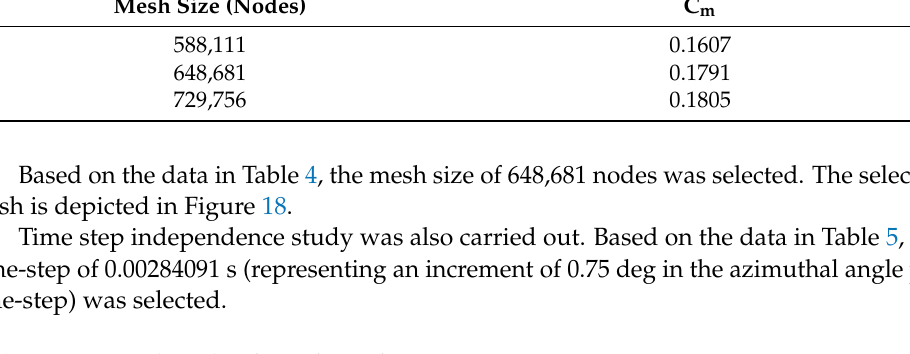
Table 4. Mesh independence data.